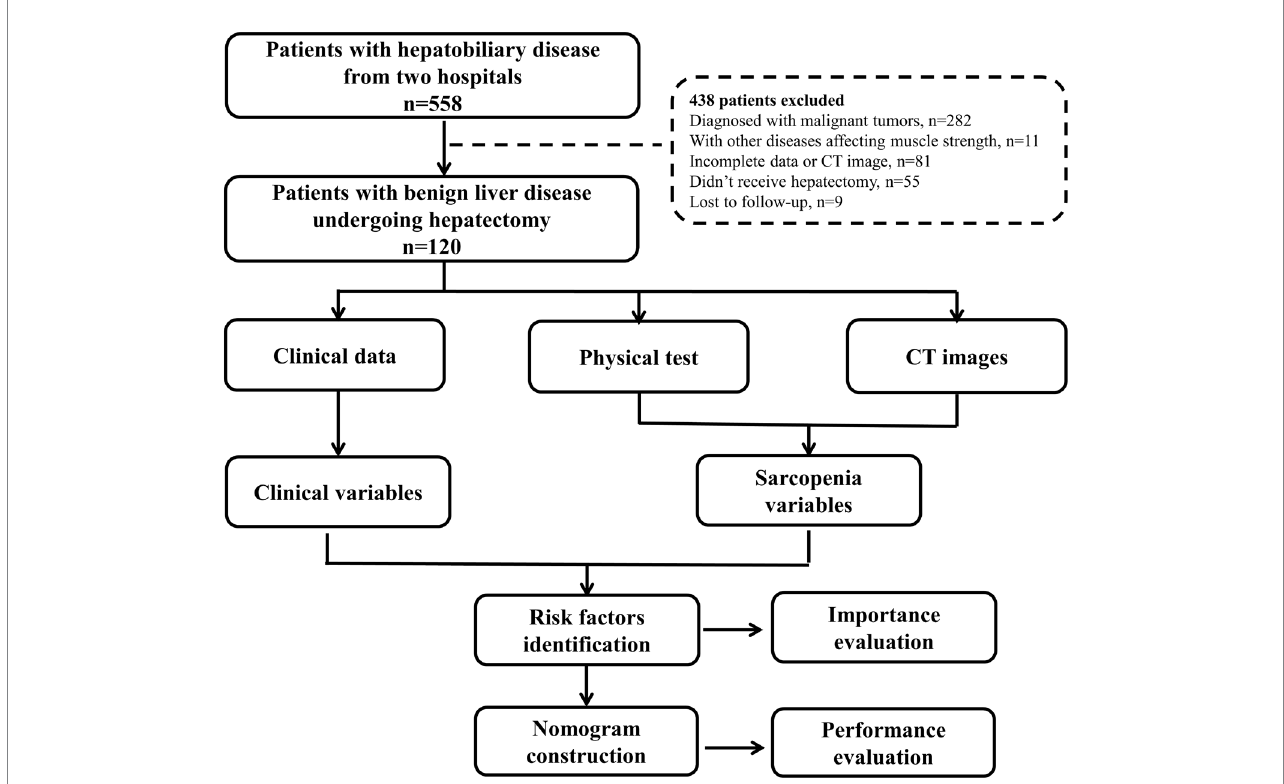
FIGURE 1 Flowchart of the study.